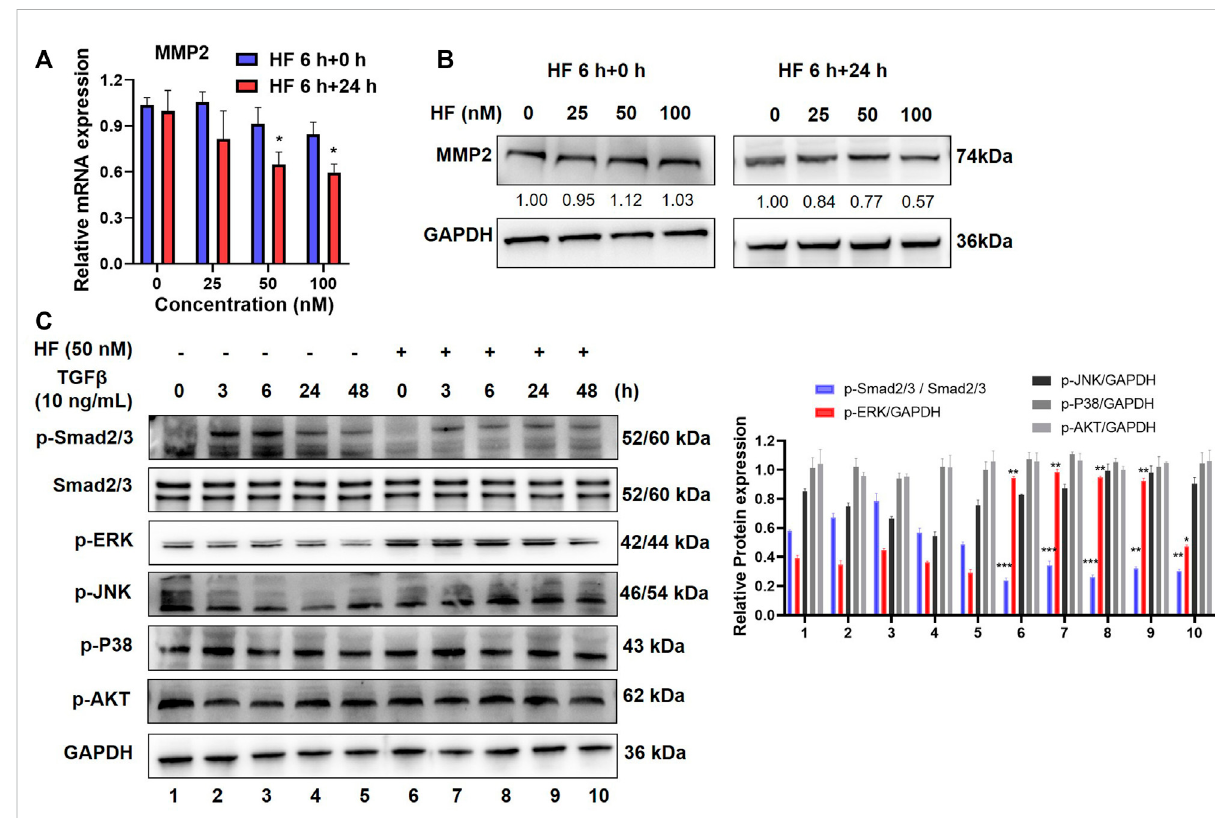
FIGURE 5 Halofuginone inhibited MMP2 expression and TGF- β /Smad2/3 signaling pathway in CAFs. (A) CAFs were treated with or without HF (25, 50, 100 nM) for 6 h and replaced with complete media and cultured for further 24 h. The mRNA level of MMP2 in CAFs was detected by qPCR. (B) The protein level of MMP2 was detected by Western bloting, and bands were quanti fi ed using ImageJ software. Similar results were seen in at least three independent experiments. *: p < 0.05. (C) CAFs were treated with HF (50 nM) for 48 h with or without TGF β (10 ng/ml, R&D) stimulation for 3 h, 6 h,24 h,and48 htostimulatetheactivationofthesignalingpathway.WesternblottingwasusedtodetectthechangesinphosphorylatedSmad2/3, ERK, JNK, p38 and AKT protein